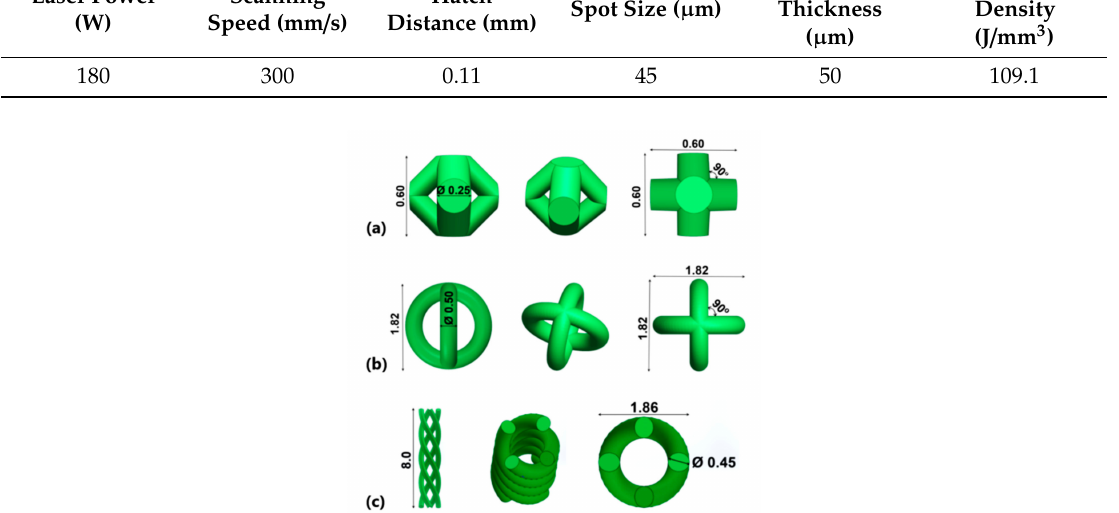
Figure 1. Virtual models of lattice topologies (mm): ( a ) body-centered cubic (BCC), ( b ) perpendicular circle intersection (PCI), and ( c ) parallel helix spirals